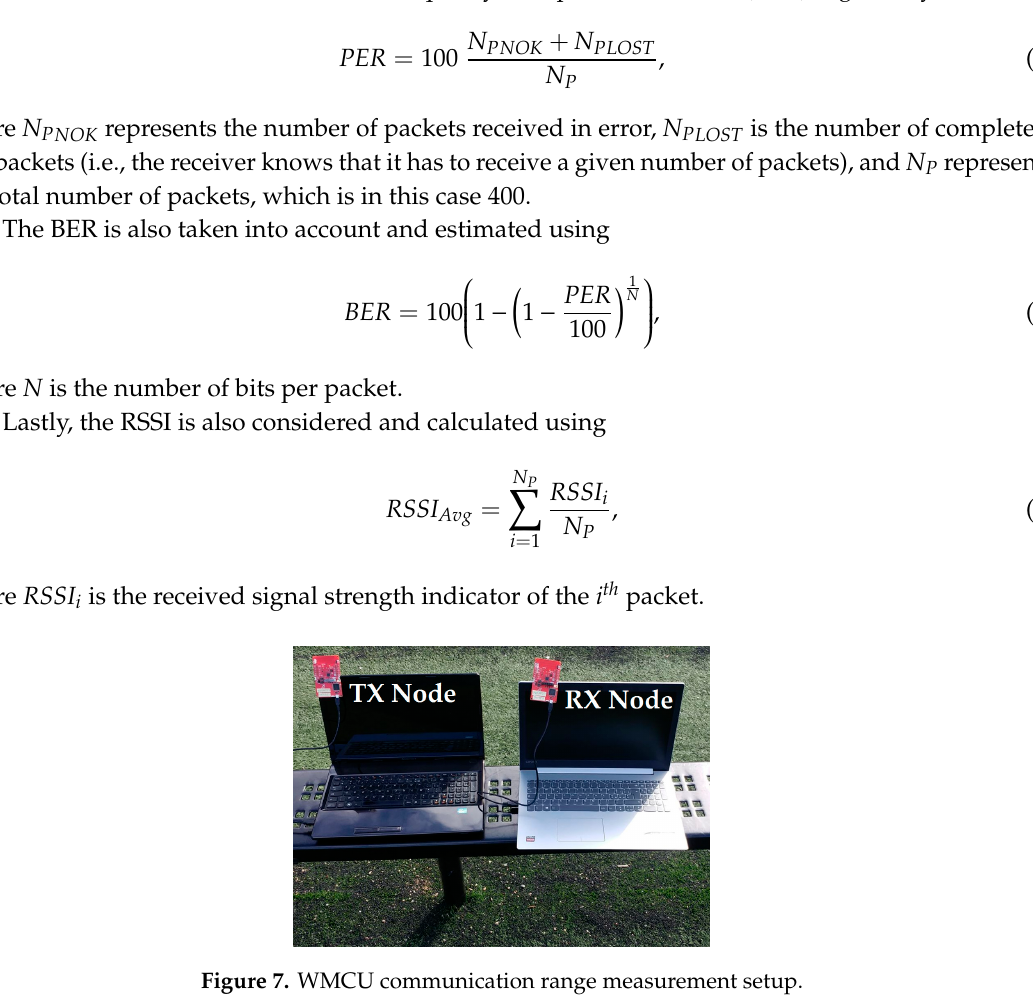
Figure 8. Measurement setup of the ambient noise. 3.2. Communication Range Outdoor Measurements In this section, the link quality characterization of a point-to-point communication link deployed in different outdoor environments (i.e., urban and suburban areas) is presented. Two different output power levels on the transmitter’s side (i.e., − 10 dBm and 0 dBm) and two different data rates on the